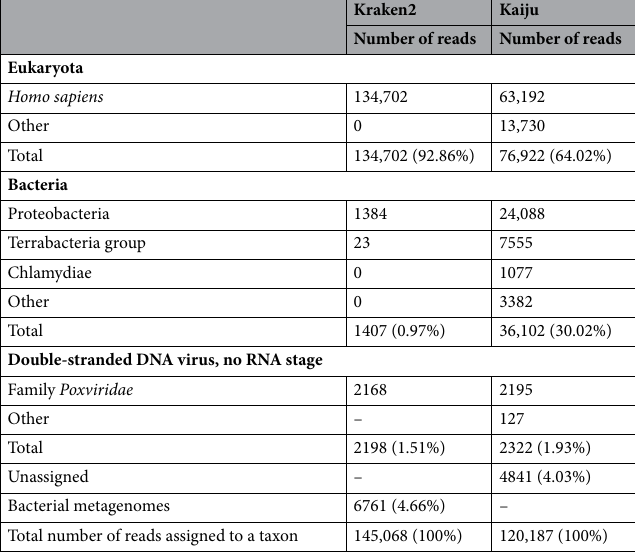
Table 1. Summary of the taxonomic assignments of the reads for each of the two classifiers used (Kraken2 and Kaiju).